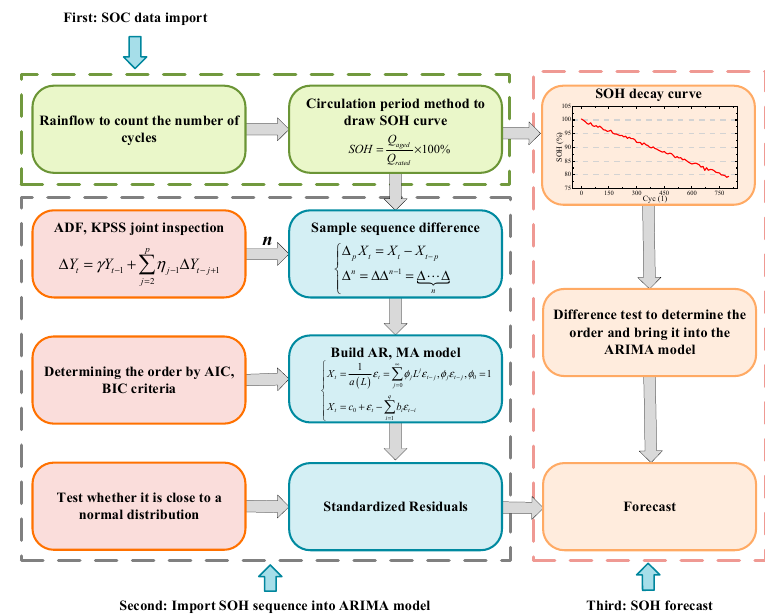
Figure 1. State of health (SOH) prediction process.